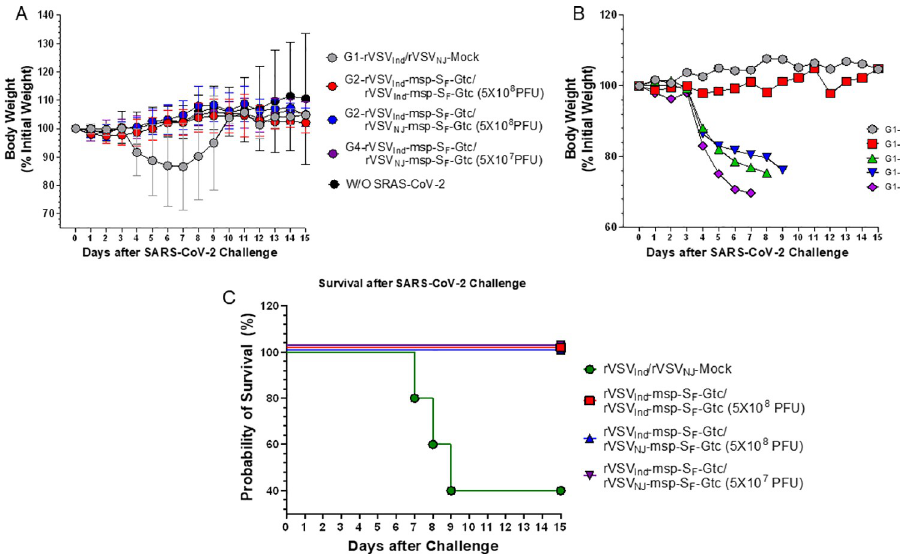
Fig 9. Bodyweight and survival of the vaccinated and SARS-CoV-2 challenged hACE2 transgenic mice. Six-week- old female hACE2 transgenic mice (n = 5 per group) were prime-vaccinated with rVSV Ind -msp-S F -Gtc and boost vaccinated with rVSV Ind -msp-S F -Gtc or rVSV NJ -msp-S F -Gtc two weeks after prime-vaccination. Four weeks after boost-vaccination (S6 Table), mice were challenged intranasally with 1x10 5 PFU of SARS-CoV-2. The survival and body weight of each mouse was monitored daily. (A) Average bodyweights of mice in each vaccinated group. (B) Individual body weights for mice vaccinated with rVSV-Mock and challenged with SARS-CoV-2. (C) Mouse survival after SARS-CoV-2 challenge. VSV-Mock denotes VSV vector alone without any gene insert.